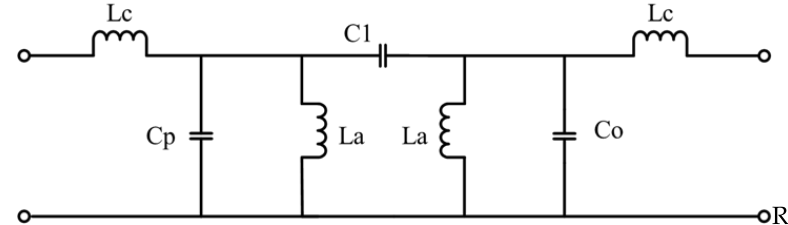
Figure 5. Simplified equivalent circuit.